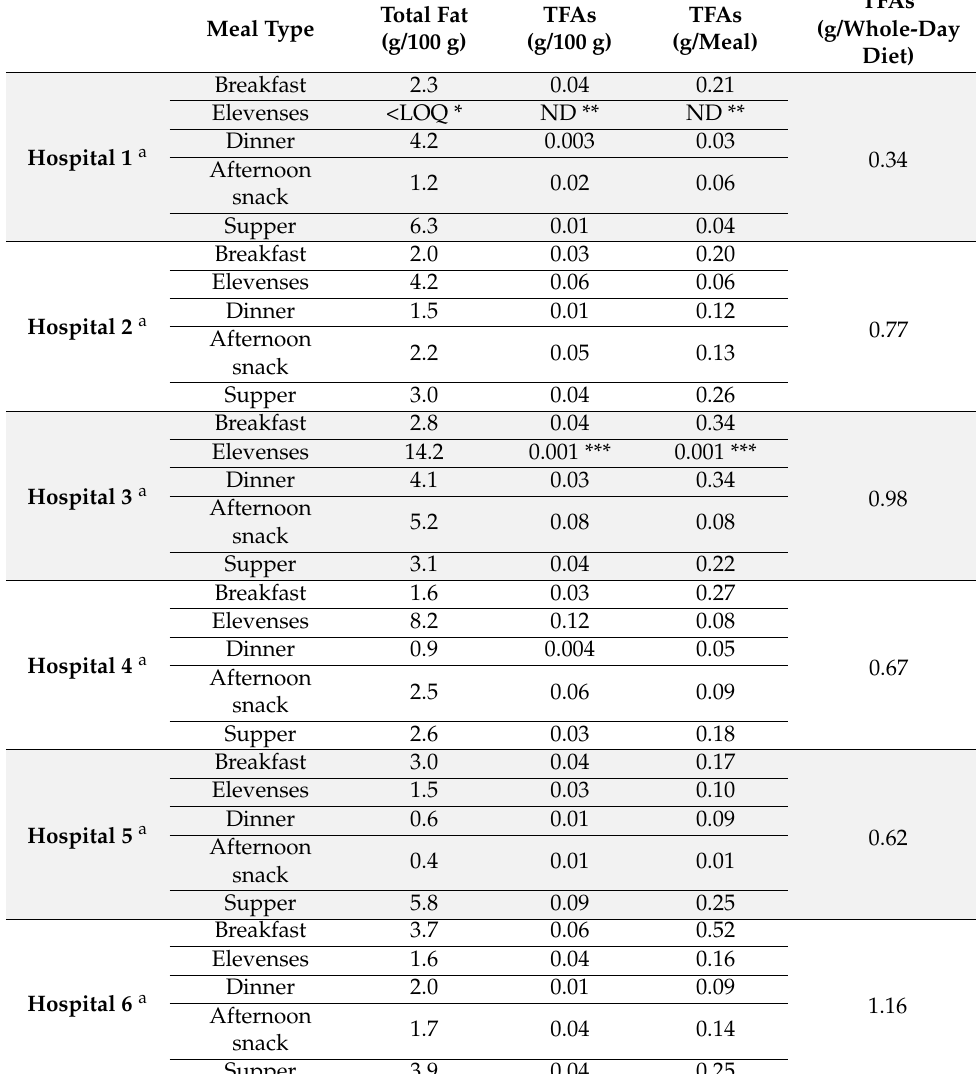
Table 3. Comparison of fat and trans fatty acid content in hospital diets in g/100 g, g/meal, and g/whole-day diet. Total Meal Type